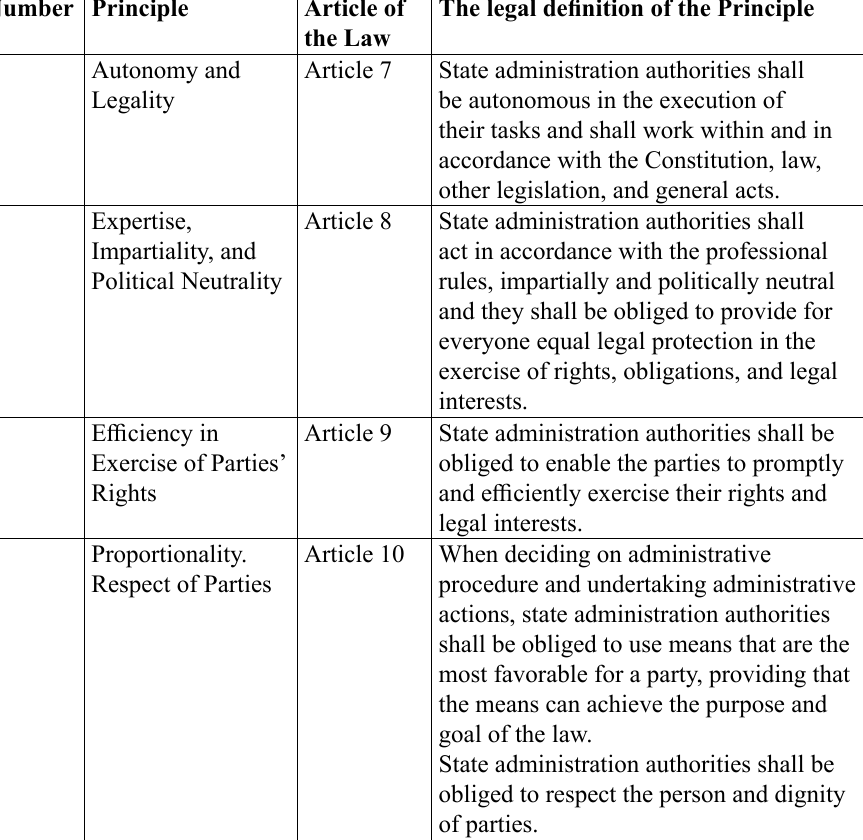
Table 2. Principles of Work of State Administration